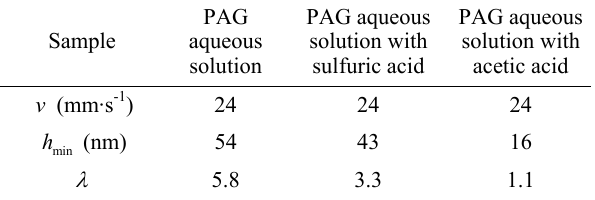
Table 1 Calculated theoretical film thickness and  values of different PAG aqueous solutions.